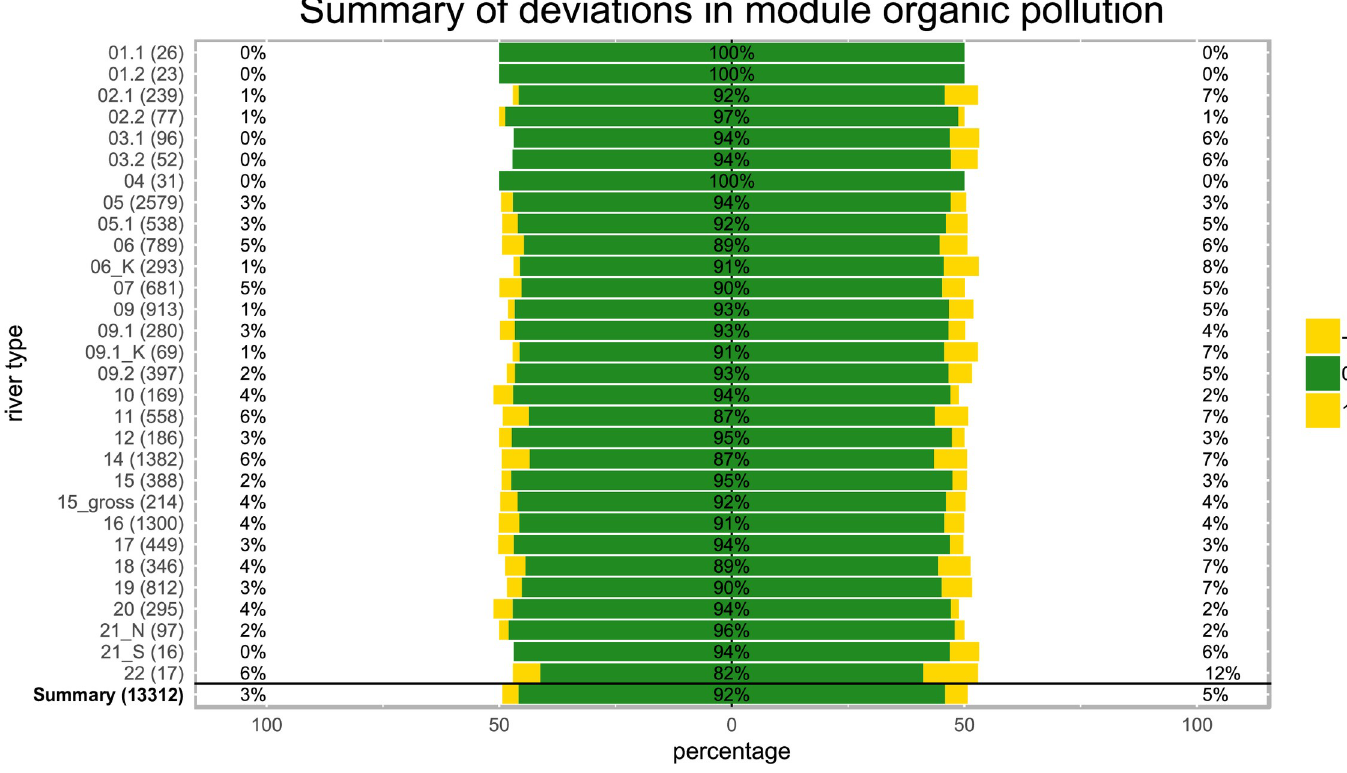
Fig 4. Deviations in organic pollution module results calculated with presence/absence data using ASTERICS for 13,312 samples from 30 different German stream types (y-axis, numbers in parentheses = data points). Green indicates assessment values that remained identical, yellow indicates values that differed by ± 1 and orange indicates value that differed by ± 2 classes. Deviations in the negative (worse) direction are shown on the left and deviations towards a more positive assessment (better) are shown on the right side.